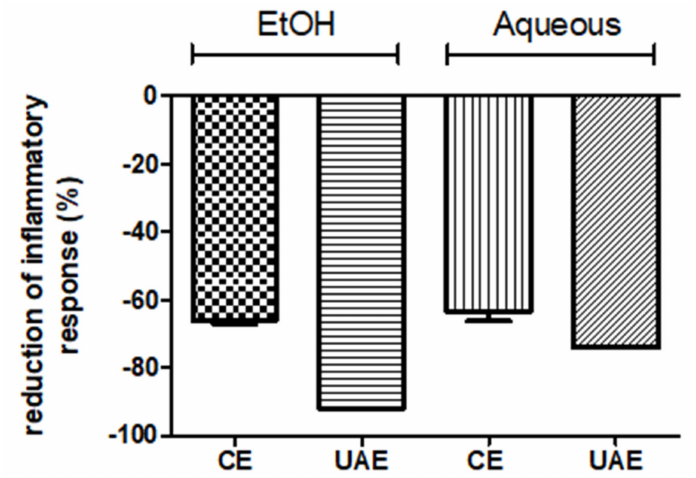
Figure 2. The e ff ect of Erodium glaucophyllum extracts on TNF- α -induced pro-inflammatory response. The diagram shows the reduction of secreted alkaline phosphatase activity (SEAP) activity (%) in the cell line reporter (HT-29 clone #16) with respect to TNF- α (0%). EtOH: hydroethanolic extract; aqueous: extracts with water. UAE: extracts obtained by ultrasound-assisted extraction; CE: extracts obtained by conventional